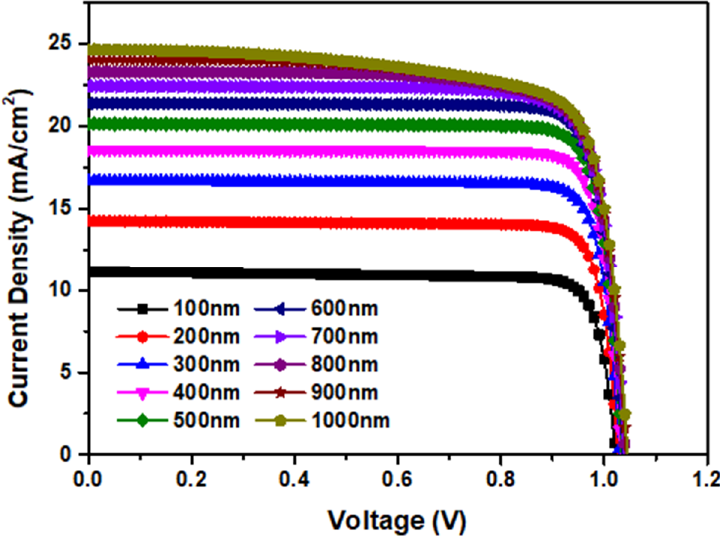
Figure 4. Current density–voltage ( J–V ) curves for various PAL thicknesses.